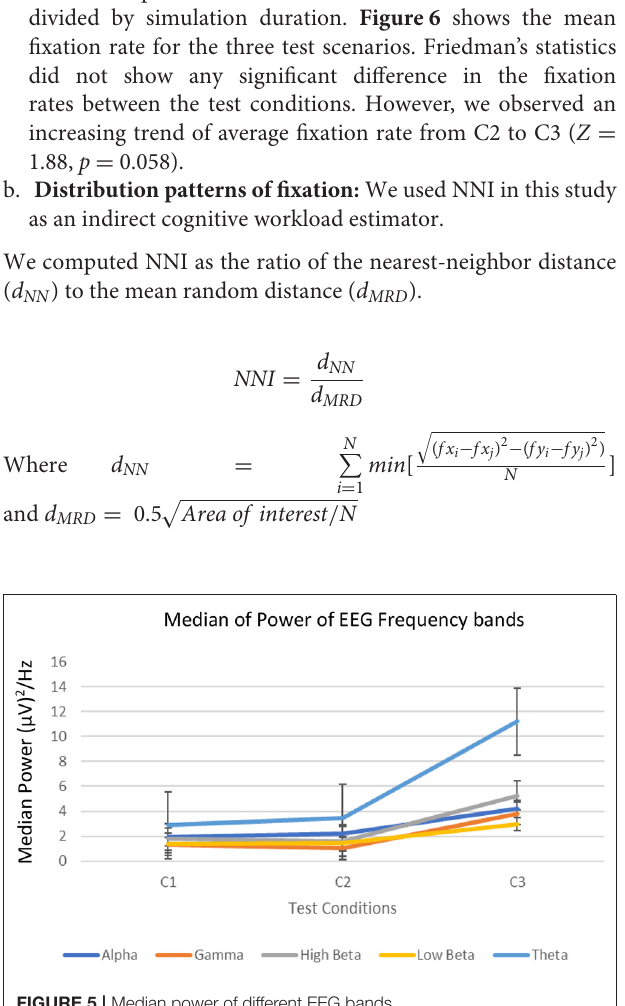
FIGURE 6 | Fixation rate.